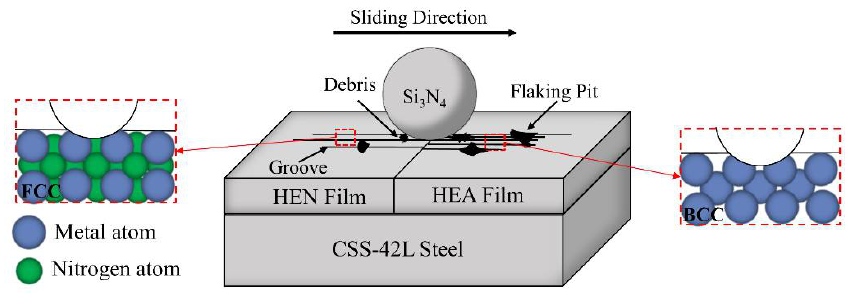
Figure 12. Three-dimensional schematic diagram of wear mechanism of HEA and HEN films.